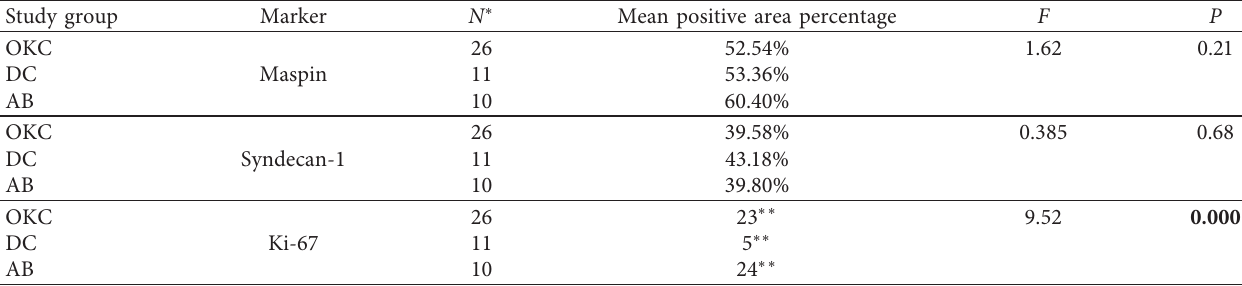
Table 2: Multiple comparisons of the mean percentages of maspin-positive areas, syndecan-1 positive areas, and the Ki-67 scores in the three diagnostic groups, using ANOVA test. A significant P -value is shown in bold font. Study group